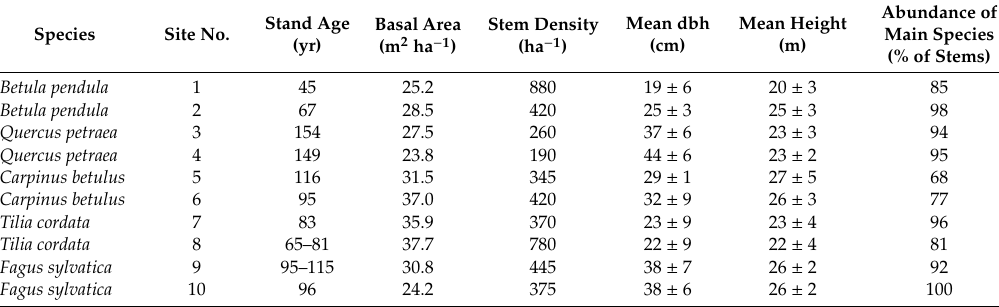
Table 2. Stand structural characteristics of the 10 studied